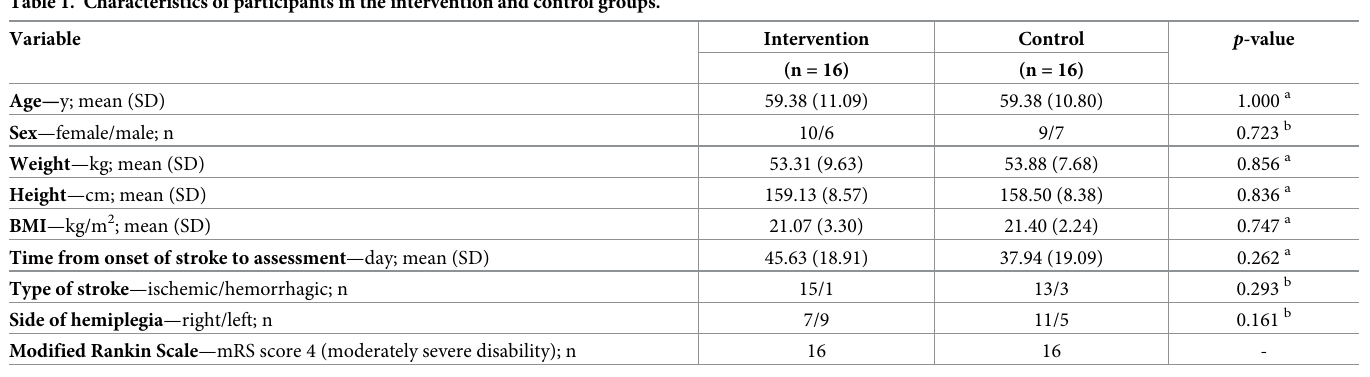
Table 1. Characteristics of participants in the intervention and control groups.